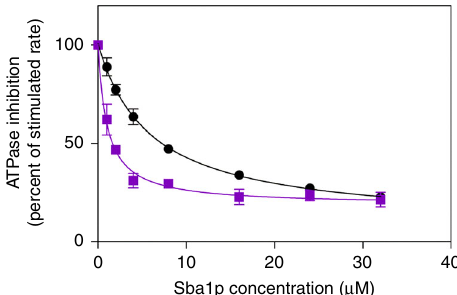
Fig. 9 Sba1 has a higher apparent af fi nity for Hsp82p in the presence of Aha1p Δ 11 . Increasing concentrations of Sba1p were titrated into reactions containing Hsp82p and either Aha1p (black circles) or Aha1p Δ 11 (purple squares) ( n = 4). Reactions contained 1 μ M Hsp82p, 5 μ M of either Aha1p or Aha1p Δ 11 , and the indicated concentration of Sba1p. Error bars show